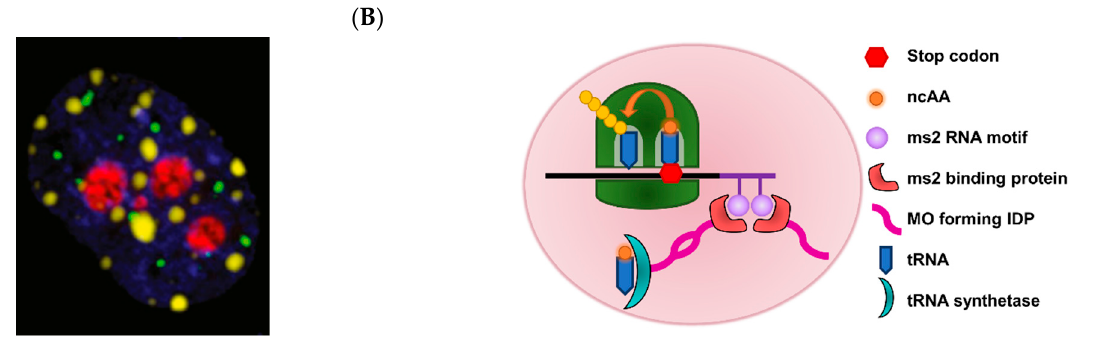
Figure 11. Eukaryotic MOs can be functionalized to host unrelated proteins. ( A ) Fluorescent microscopy of MOs in HeLa cells: Ddx4 (part of nuage) is fused to a yellow fluorescent protein (YFP), nucleoli colored red, and nuclear bodies colored green. Reprinted from Baldwin and co-workers [126]. Copyright 2015 Elsevier. ( B ) A synthetic MO in HEK293 cells enhanced the incorporation of the ncAA, Pyl, into proteins. Adapted from Lemke and co-workers [127]. Copyright 2019 Reinkemeier, C.D. et al.